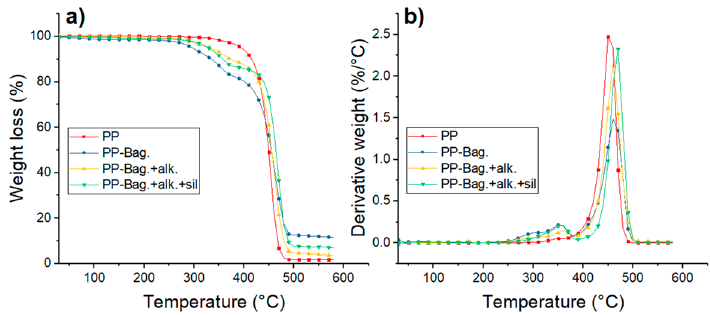
Figure 7. ( a ) TG and ( b ) DTG curves for first processing cycle PP and PP-Bagasse biocomposites.